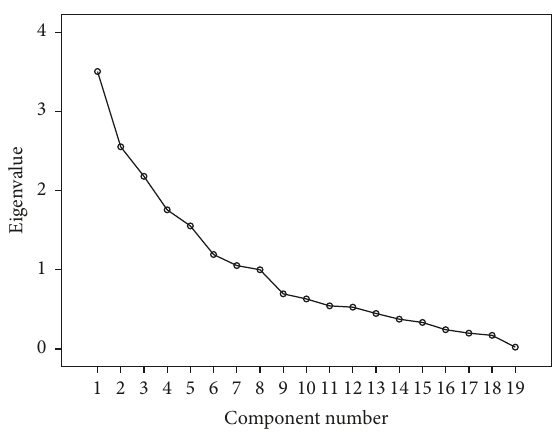
Figure 4: Scree plot for beliefs domain: construct validity.